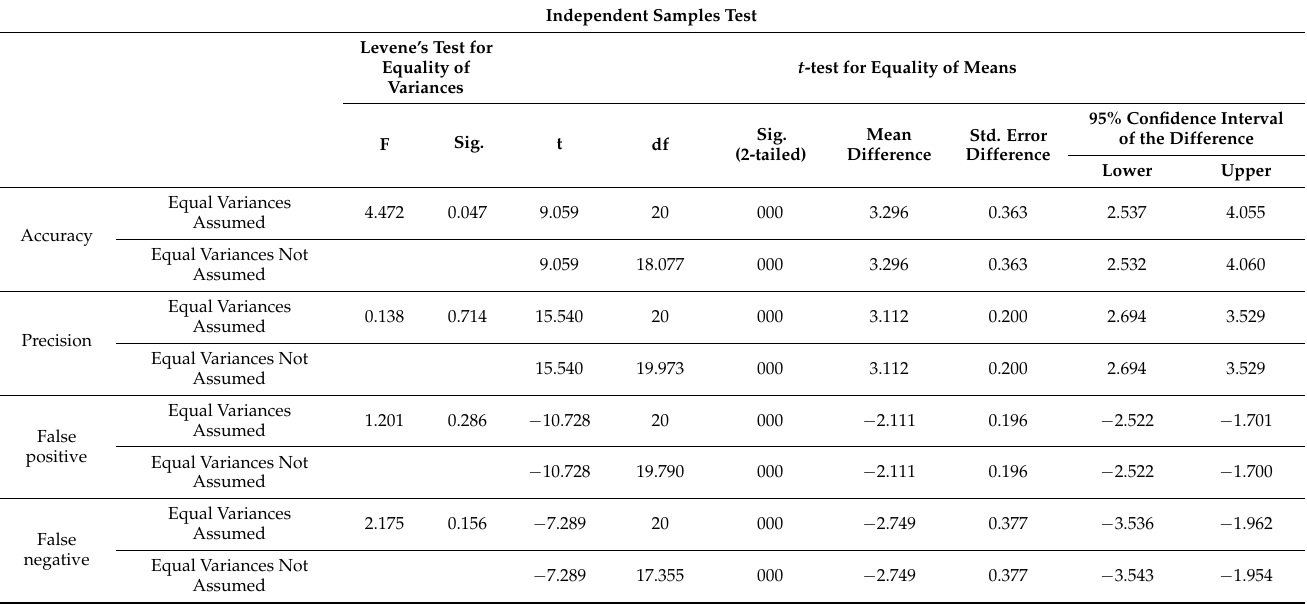
Table 6. Independent sample test for CNN and KNN for significance calculation statistics.